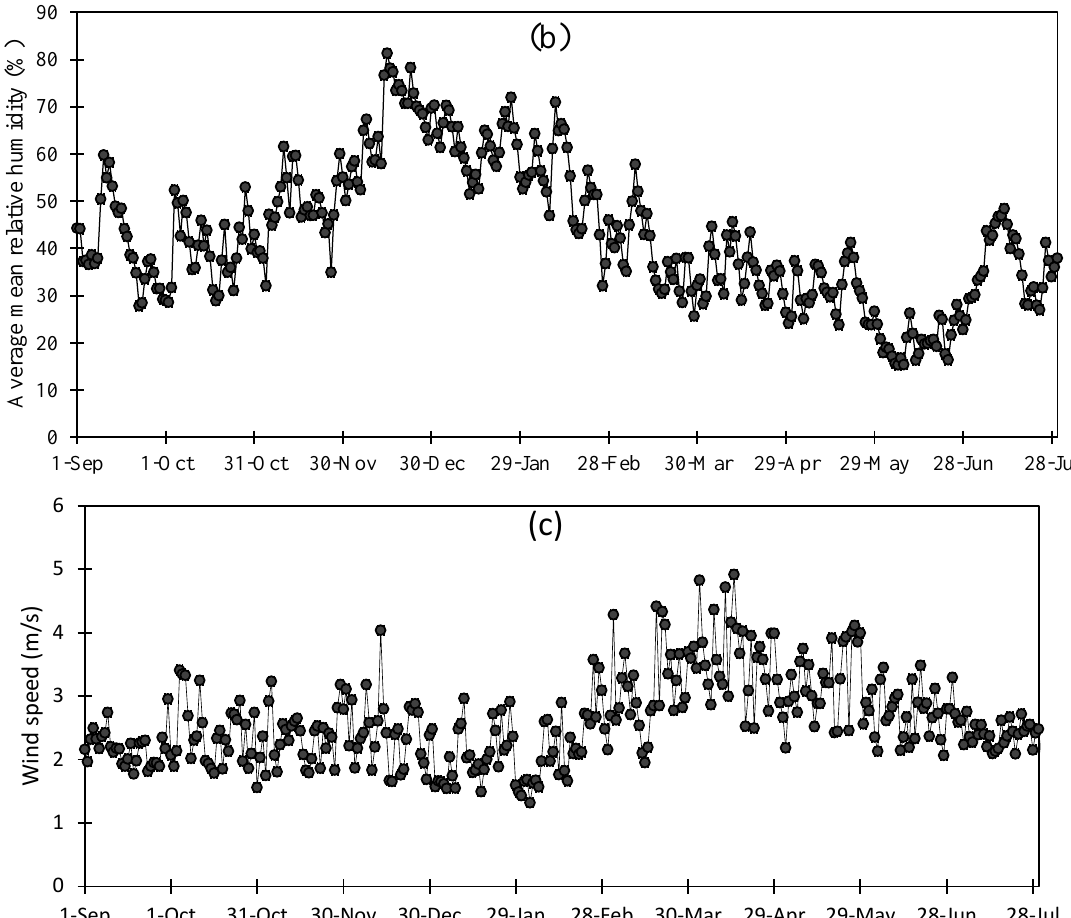
Figure 2. Trends in the average ( a ) Daily solar radiation; ( b ) Relative humidity; ( c ) Wind speed for the period of 1st September to 31st July.